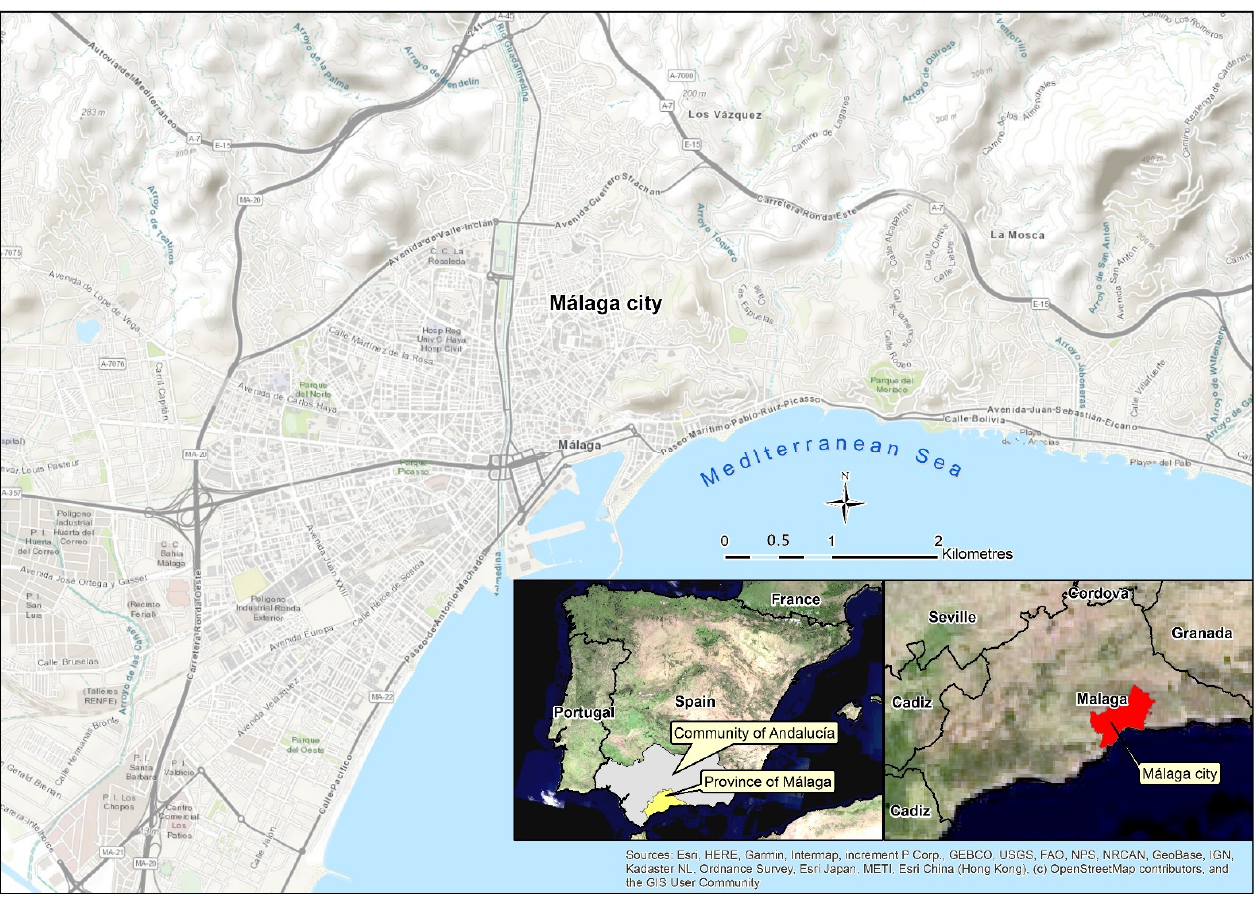
Figure 1. Location and general features of the study area (Málaga, Spain).